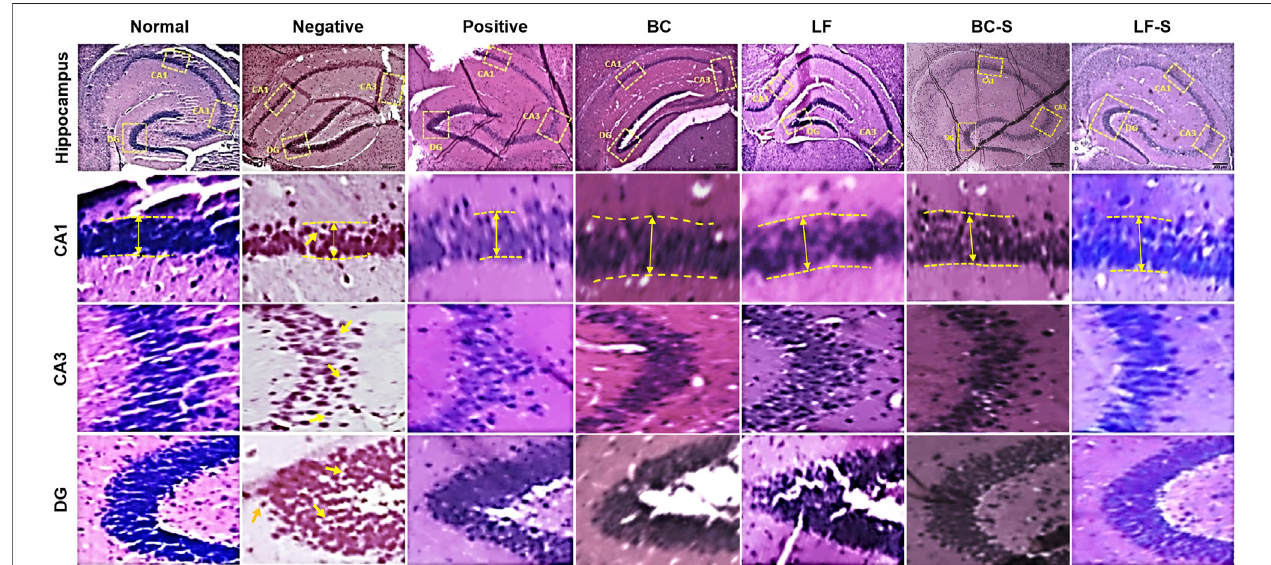
FIGURE3| Effectsof Lactobacillus fermentum NMCC-14 (10 10 CFU/day, p.o) and Bacillus clausii (10 10 CFU/day, p.o) onthe hippocampus CA1, CA3,and DGof acute restraint-stressed and normal mice. Lactobacillus fermentum NMCC-14 (10 10 CFU/day, p.o) and Bacillus clausii (10 10 CFU/day, p.o) improved stress-induced neurodegenerative changes in the hippocampus CA1, CA3, and DG regions (H&E staining; magni fi cation ×10, scale bar: 200 µm).